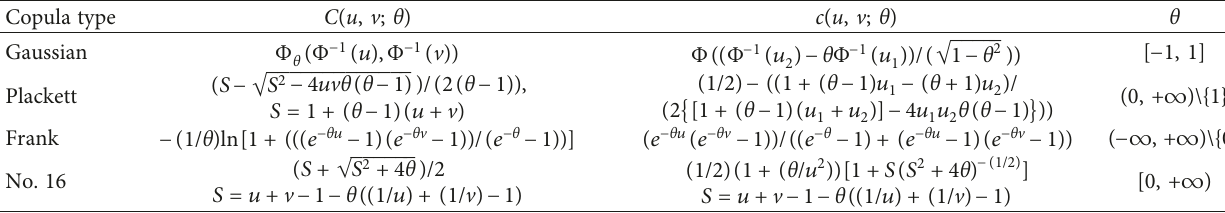
Table 5: Copulas selected in this study.